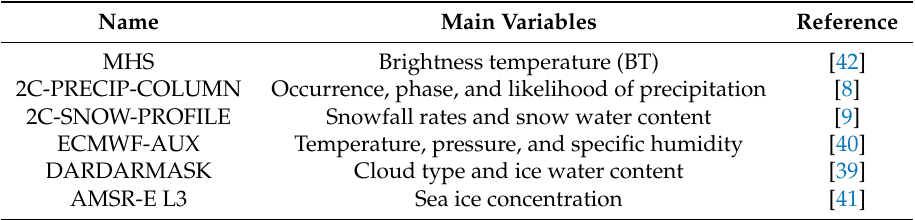
Table 2. Summary of the products used in this study. AUX, auxiliary; AMSR-E, Advanced Microwave Scanning Radiometer for